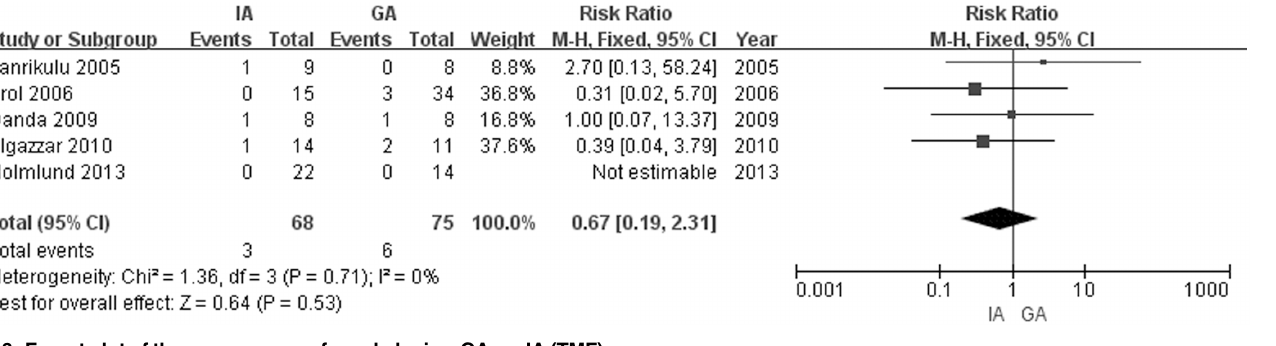
PLOS ONE | DOI:10.1371/journal.pone.0127652 May 26,